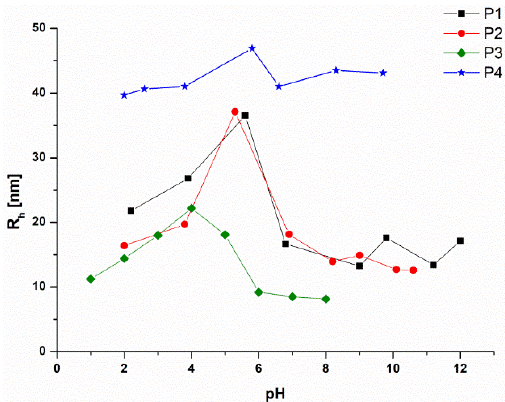
Figure 5. The average hydrodynamic radius as a function of pH for P(DMAEMA- co -OEGMA-OH) stars (the lines are guides for the eye) (c = 1 mg/mL, 90°, 25 °C).